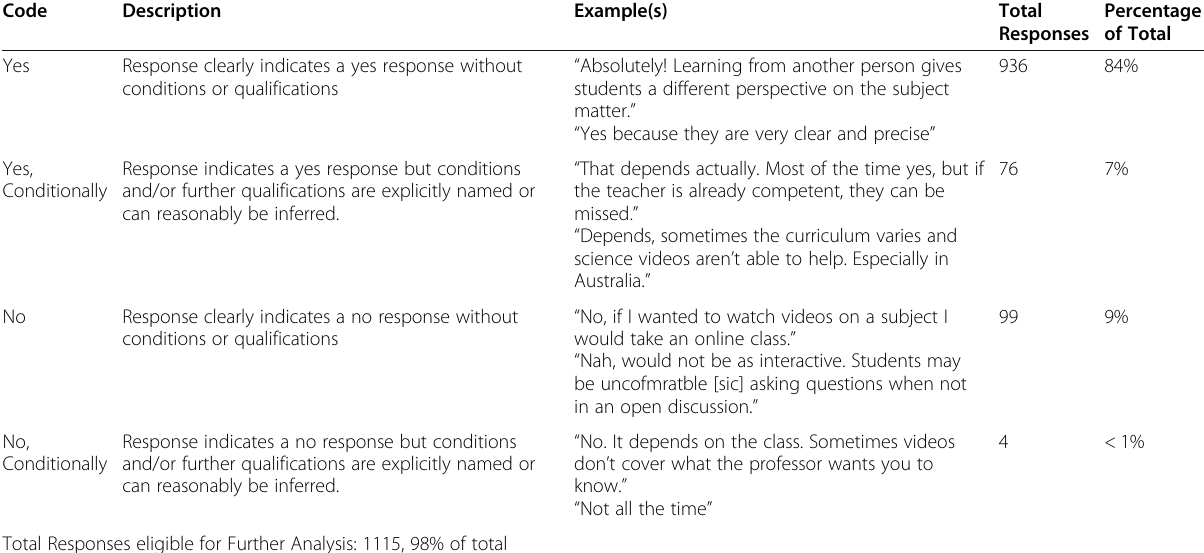
Table 4 Primary Coding Scheme